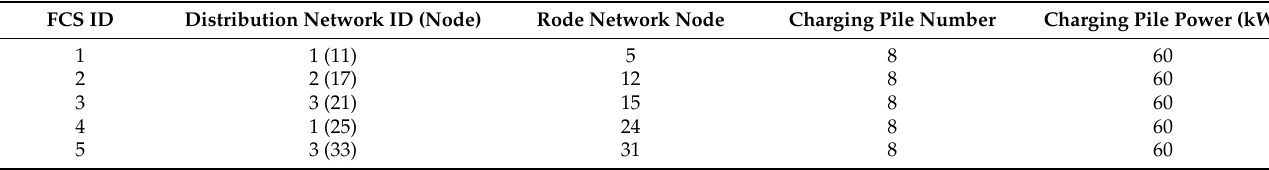
Figure 7. Topological structure of power system. Table 4. Case data.